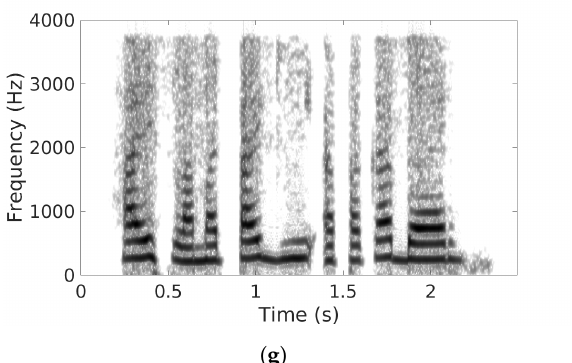
Figure 7. The spectrogram of female speakers: “hai selamat pagi apa kabar” of ( a ) original speech, ( b ) the decrypted speech from I-ADPCM, the enhanced speech from ( c ) the Wiener filter, ( d ) KLT, ( e ) LogMMSE, and ( f ) NMF, and ( g ) the the proposed method.